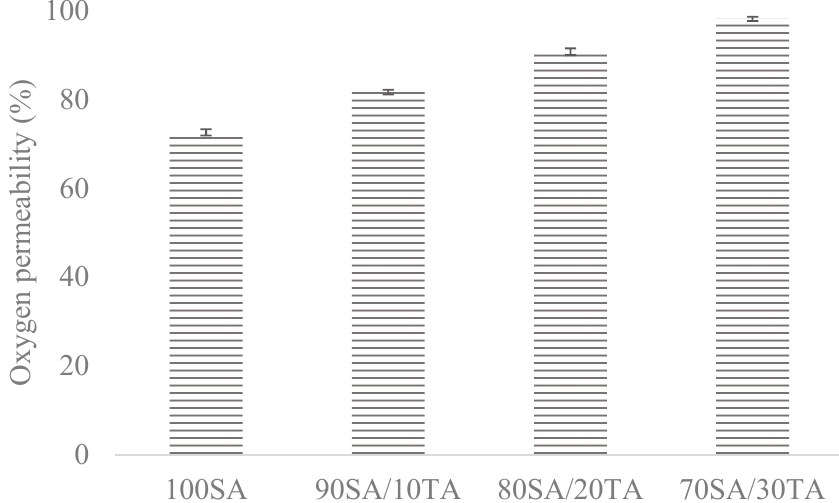
Figure 4. Oxygen permeability through films based on sodium alginate modified by tannic acid addition. Results are presented as percentage permeability vs. control (permeability